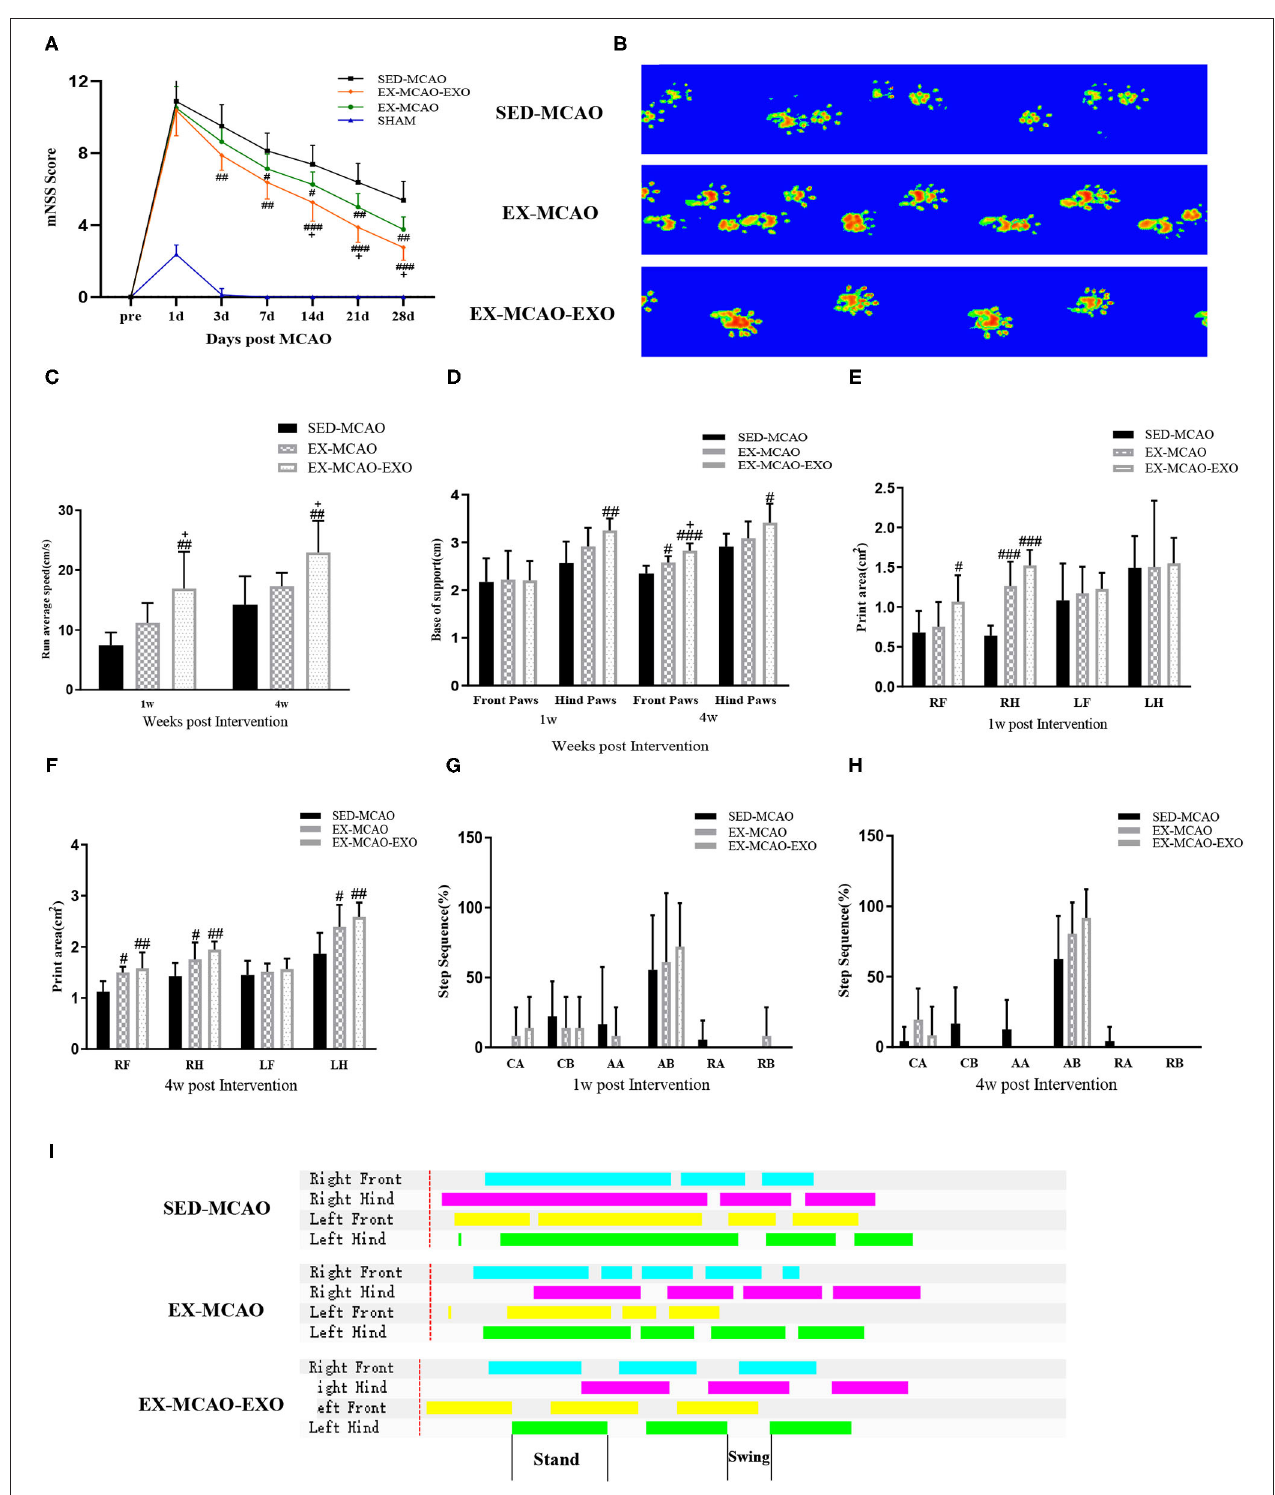
FIGURE 7 | Neurological results and gait analysis of rats after the exercise intervention. (A) mNSS score. Means ± standard deviations, n = 8/group. (B) Representative paw prints. (C) The average movement speed of MCAO rats after 1 w and 4 w of exercise intervention. (D) The base of support of MCAO rats after 1 w and 4 w of exercise intervention. (E,F) The paw print area of the four paws of MCAO rats after 1 w and 4 w of exercise intervention. (G,H) Step sequence of MCAO rats after 1 w and 4 w of exercise intervention. (I) The plain view of the gait. LF, left forepaw; RF, right forepaw; LH, left hindpaw; RH, right hindpaw (R is the affected side). Step sequence: CA, right forepaw → left forepaw → right hindpaw → left hindpaw; CB, left forepaw → right forepaw → left hindpaw → right hindpaw; RA, right forepaw → left forepaw → left hindpaw → right hindpaw; RB, left forepaw → right forepaw → right hindpaw → left